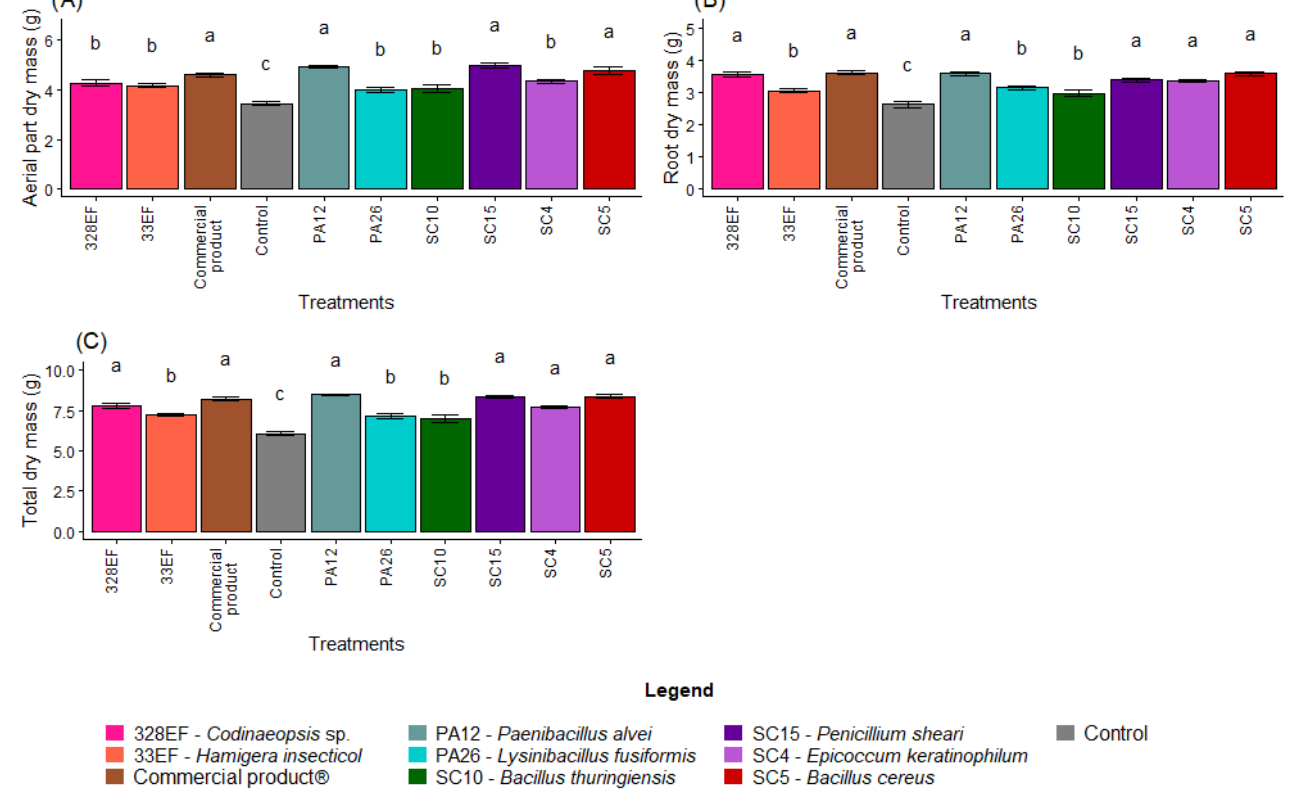
Figure 1. Dry mass of aerial part ( A ), root dry mass ( B ) and total dry mass ( C ) in soybean ( Glycine max) plants inoculated with fungal and bacterial strains isolated from Hymenaea courbaril and Butia purpurascens and grown in a controlled greenhouse system. Means followed by the same letter were not significantly different using the Scott – Knott test at 0.05% probability.